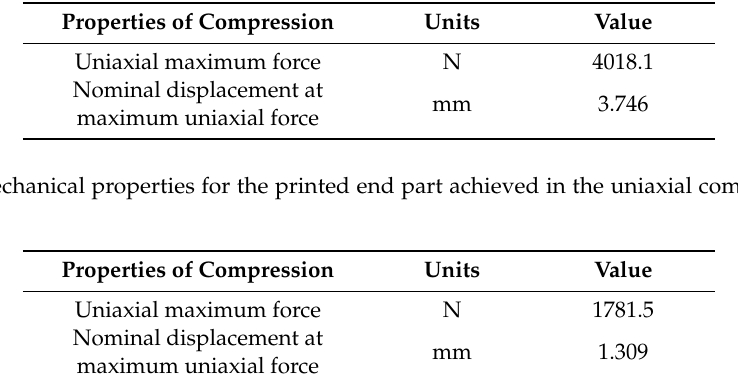
Figure 13. Uniaxial compression load facing nominal displacements for the X-axis printed part tested. Table 9. Mechanical properties for the printed part achieved in the uniaxial compression test in Z-axis.